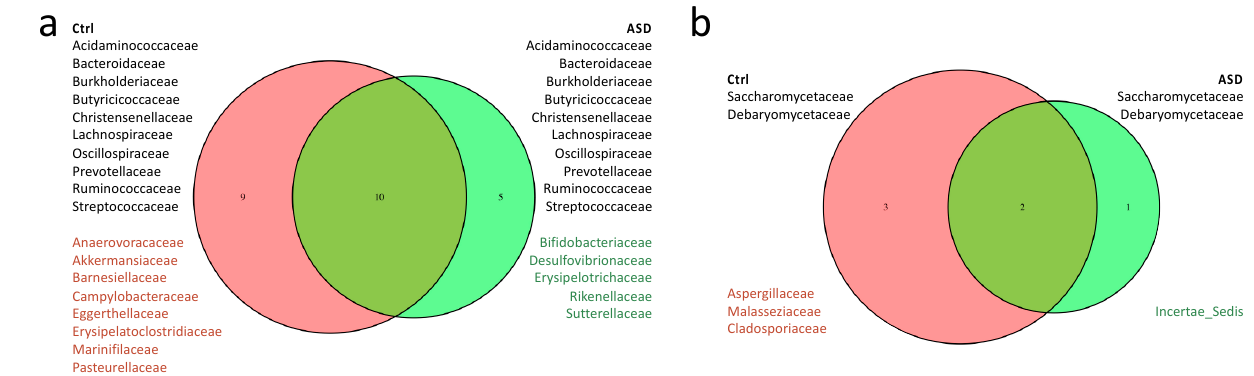
Figure 2. Venn diagrams of ( a ) microbiota and ( b ) mycobiota taxonomic analysis. In black, common families between ASD and Ctrl samples; in red, families mainly present in Ctrls; in green, families characterising the ASD